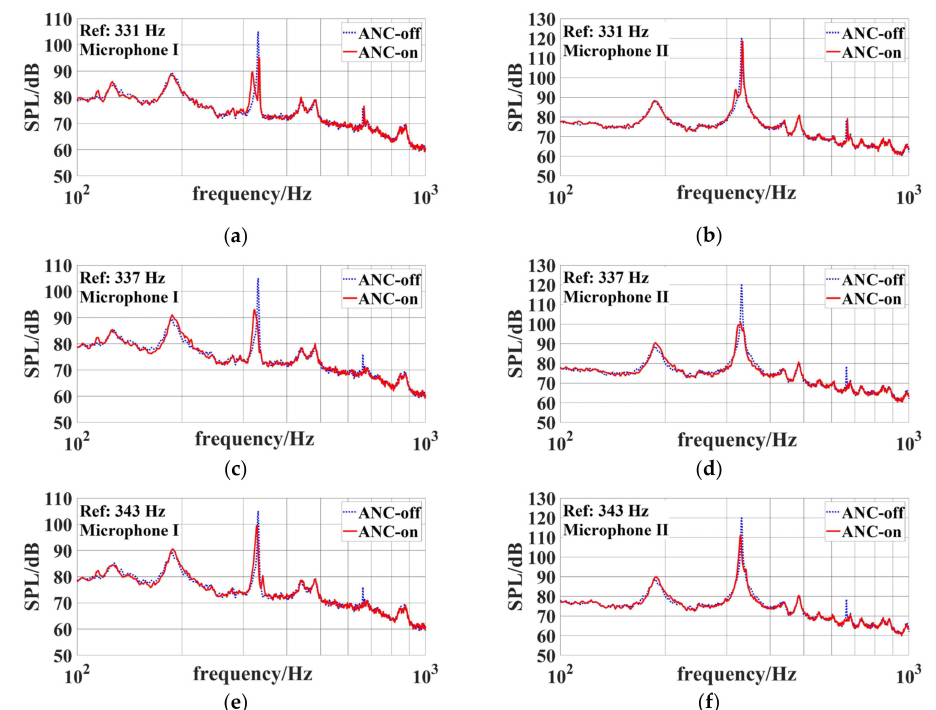
Figure 10. Experimental results with 261 mm cavity: the noise spectrum at the test ( a ) microphone I and ( b ) microphone II with a 331 Hz (resonance frequency) reference; the noise spectrum at the test ( c ) microphone I and ( d ) microphone II with a 337 Hz reference (best); the noise spectrum at the test ( e ) microphone I and ( f ) microphone II with a 343 Hz